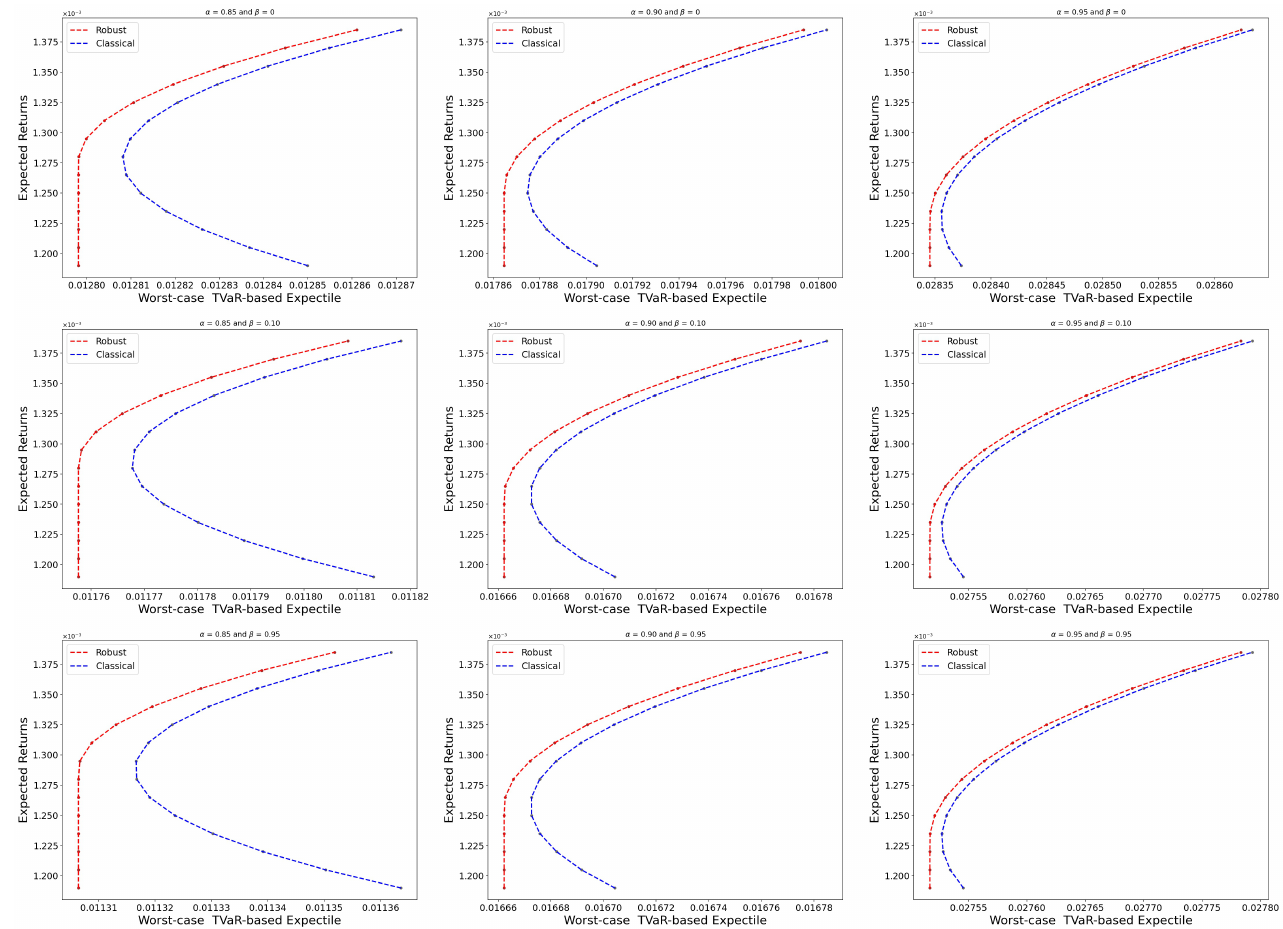
Figure 1. The effective boundaries of the classical investment strategy and robust investment strategy based on the worst-case TVaR-based